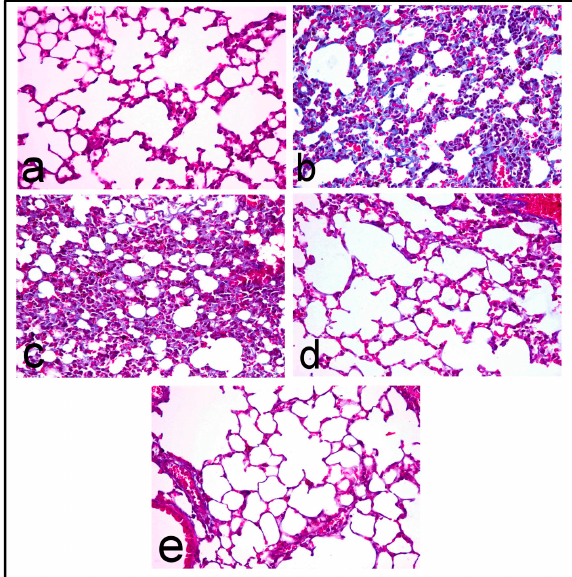
Figure 4. Lung of ( a ) control mice showing no collagen deposition; ( b ) BLM-treated mice showing intensely blue collagen fibers; ( c ) PRO-25 treated mice showing blue stained collagen fibers; ( d ) PRO-50 treated mice showing no collagen deposition; and ( e ) PRO-100 treated mice showing no collagen deposition. (Masson’s trichrome stain, 400×).